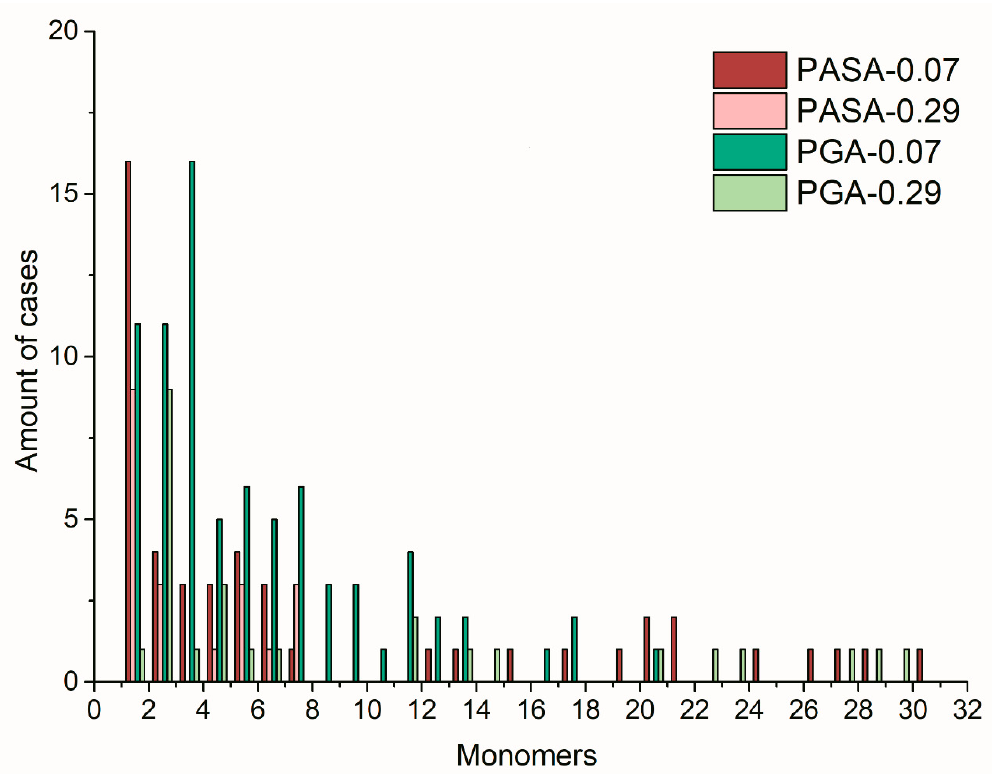
Figure 9. Distribution of the distances along the chain between monomers connected by calcium bridges.